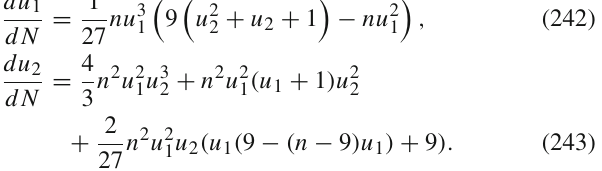
Fig. 9 Numerical solutions of the system (242), (243)